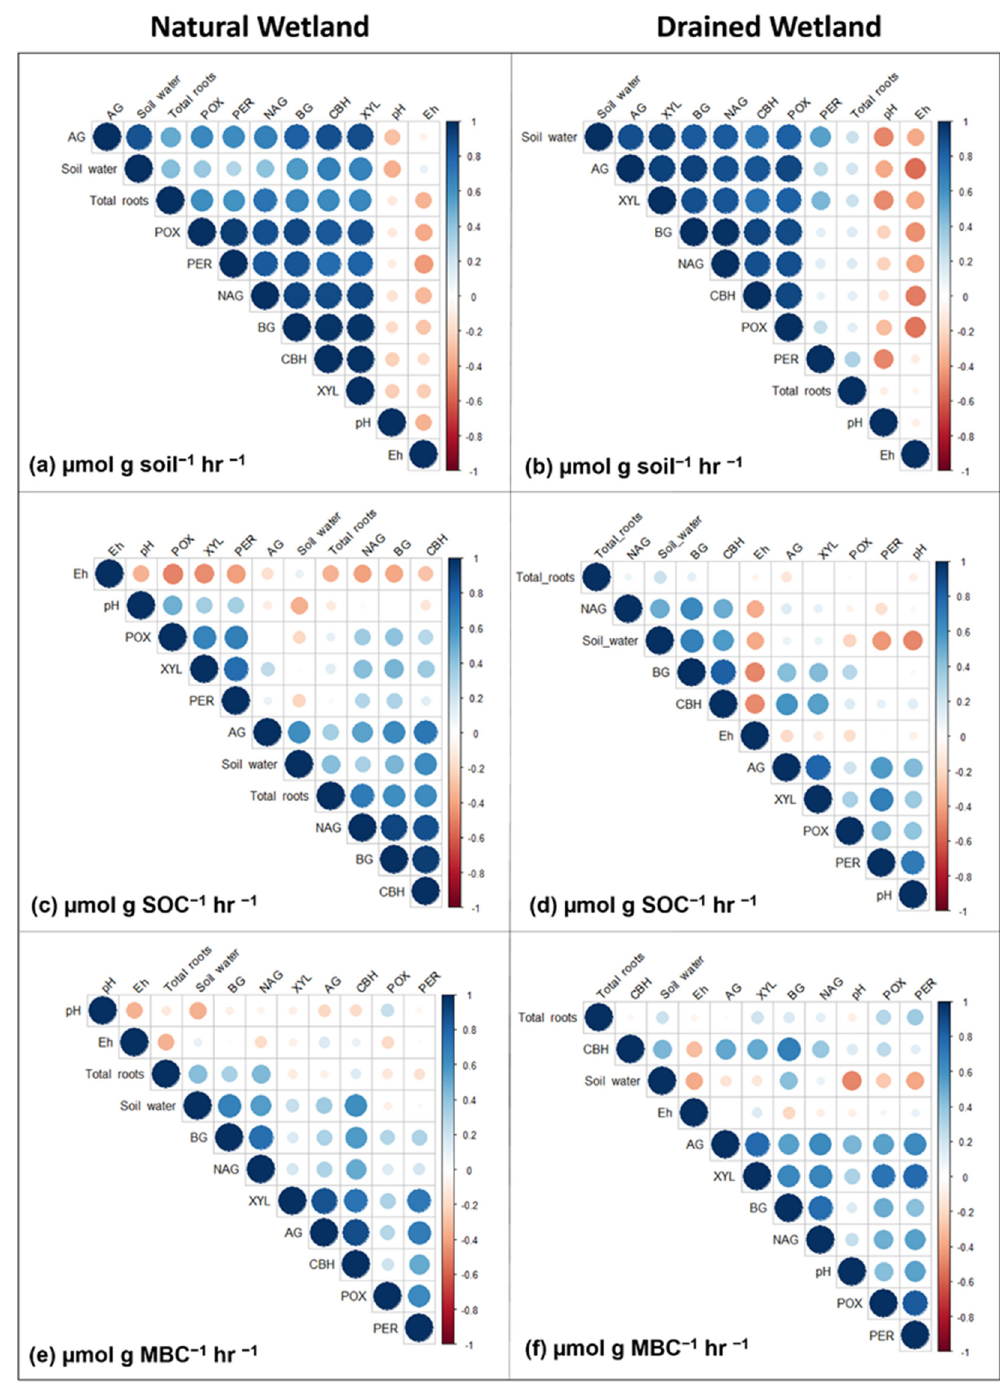
Figure 5. Plot showing correlation coefficients (r) between environmental variables and enzyme activity calculated three ways for natural ( a , c , e ) and drained ( b , d , f ) forested wetland sites in eastern North Carolina. Activity of seven enzymes were measured: α -glucosidase (AG), β -glucosidase (BG), cellobiohydrolase (CBH), xylosidase (XYL), phenol oxidase (POX), peroxidase (PER) and N-acetyl glucosamide (NAG). The colored gradients at the side of the plot indicate the level of correlation and whether it is positive (blue) or negative (red). The size of the circles also indicates the degree of correlation. Larger/brighter color circles have higher correlation and smaller/faded color circles have lower correlation. Data area averaged over soil horizons.